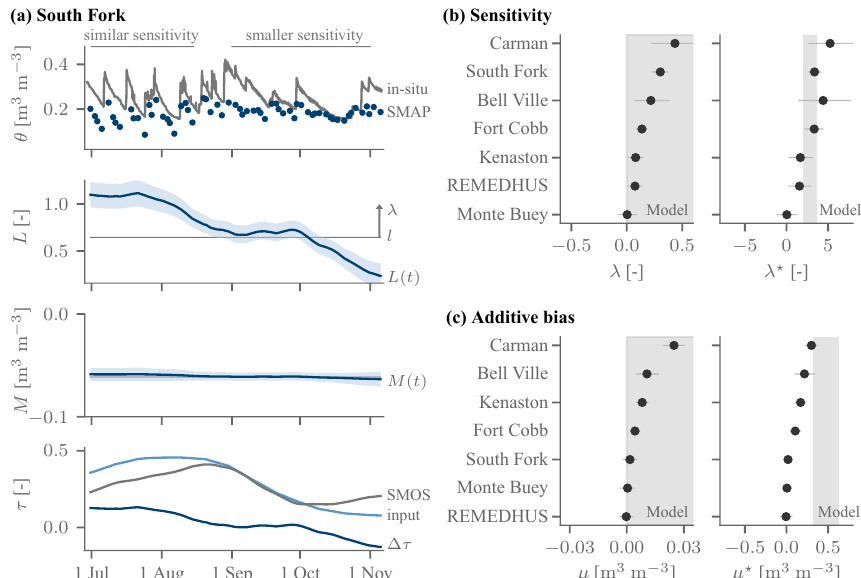
Figure 4. Time-variable biases over the network sites. (a) The SMAP product’s sensitivity decreases from summer to late autumn 2015 at the South Fork site (42.4 ◦ N, 93.4 ◦ W), which is reflected by a decrease in the inferred sensitivity L that tracks a decrease in (cid:49)τ : in early summer L(t) ≈ 1, but it subsequently drops well below the time-average value of l = 0 . 7. Its temporal standard deviation is given by λ = 0 . 3 (arrow). M(t) is approximately constant ( M(t) ≈ m ) because µ is small (not shown). (b) Over the network sites, the association of changes in the sensitivity with changes in (cid:49)τ is predominantly positive (marker: posterior median, lines: 5%–95% uncertainty), as predicted by the model (positive λ ; grey background). The magnitude of the dependence for a unit change in (cid:49)τ , λ ∗ of Eq. (10), is broadly consistent with predictions by the τ − ω model of Sect. 4.1.2. (c) The additive biases are of the right direction (positive), but the unnormalized quantities µ ∗ smaller than predicted by the model.